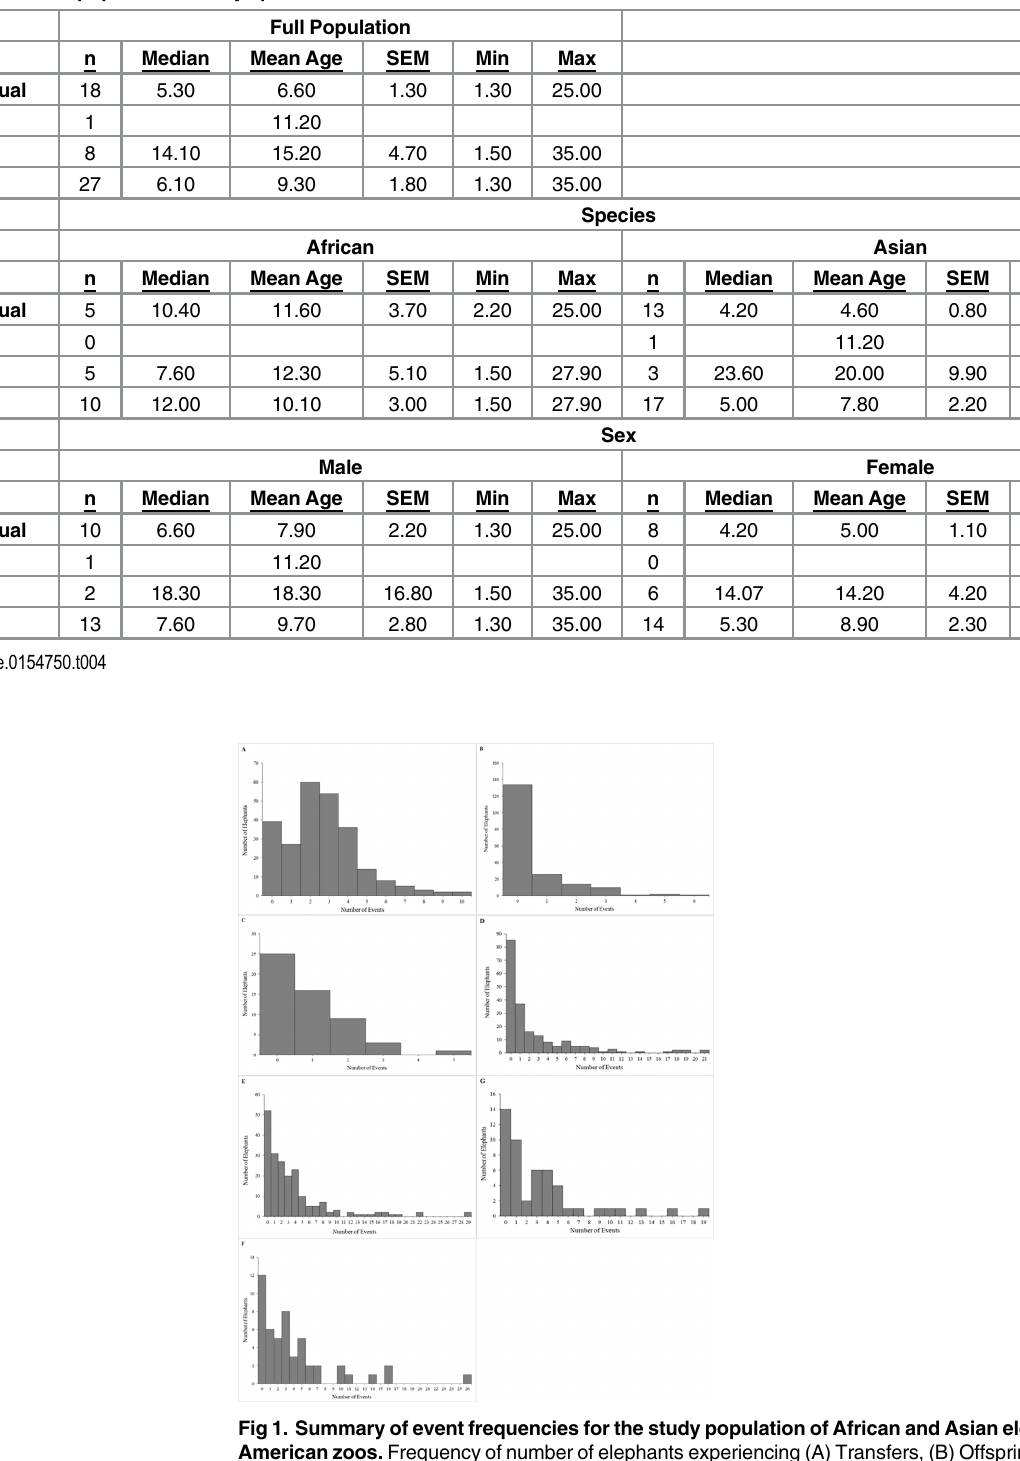
Table 4. Age at separation (median, mean, SEM, minimum and maximum) from mother due to either transfer of individual, transfer of mother, or death of mother for the full population and by species and sex.